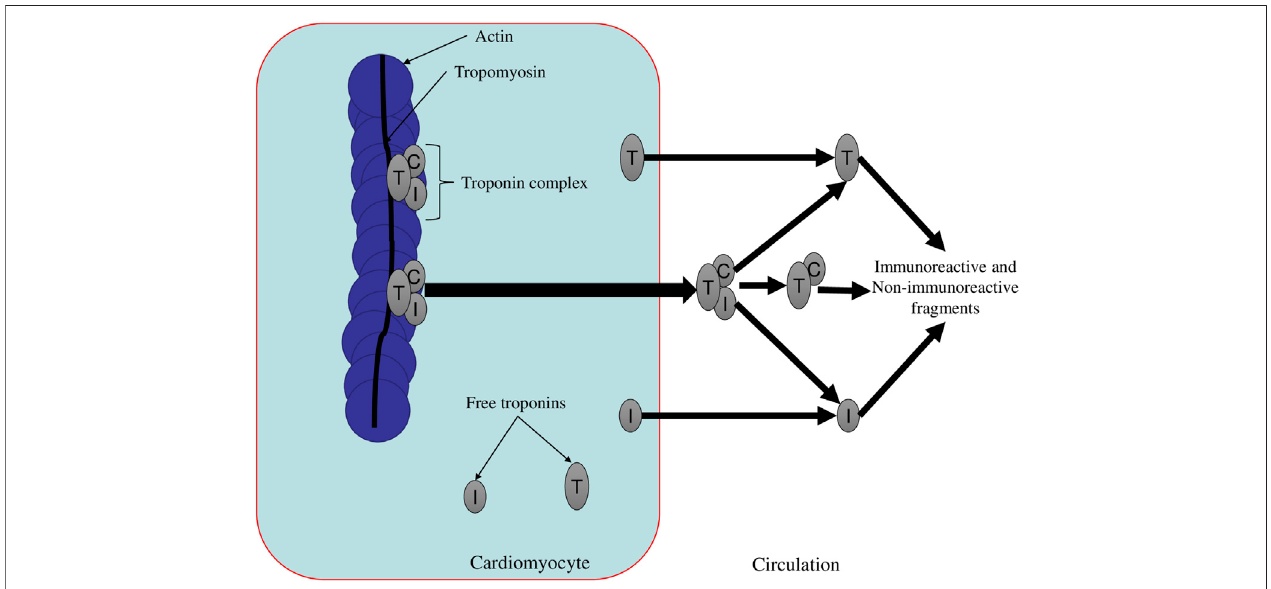
FIGURE 3 | The main forms of circulating cardiospeci fi c troponins (Gaze and Collinson, 2008). Description. The troponin complex is released from damaged cardiomyocytes(forexample,innecrosis)invariousmolecularforms.Thetriplecomplex(TnT-TnI-TnC)degradesintoabinarycomplexandfreecardiospeci fi cTns.Then the binary complex also degrades into free Tns and troponin fragments (both immunoreactive and non-immunoreactive fragments). Free cardiospeci fi c Tns can be releasedfrom cardiomyocytes with minor injuries (psychoemotional stressand physical exertion) and then also degradeintofreecardiospeci fi ctroponins (TnT and TnI) and their fragments (Gaze and Collinson,